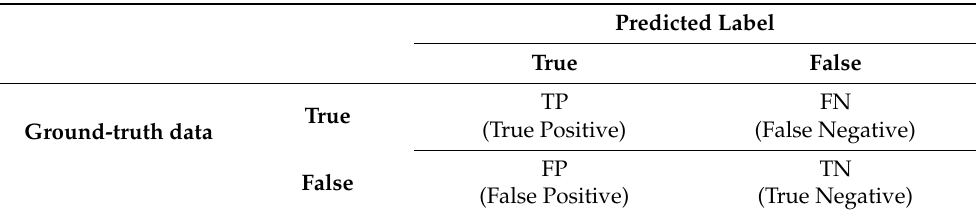
Table 1. Confusion